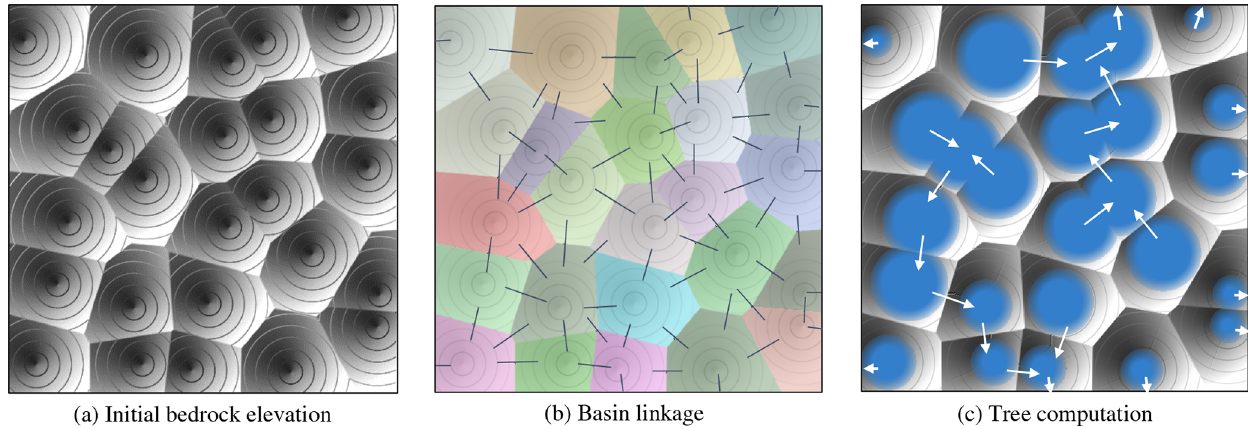
Figure 3. Our algorithm of flow enforcement run on a synthetic case. (a) Hillshade and contour plot of the input topography with apparent depressions. (b) Basins (areas of unique, random colors) and all passes connecting adjacent basins (thin black lines). (c) Flow directions across the basins (white arrows), as resulting from the computation of a minimum spanning tree from the basin graph, and water level (blue areas) after some erosion is applied to the input